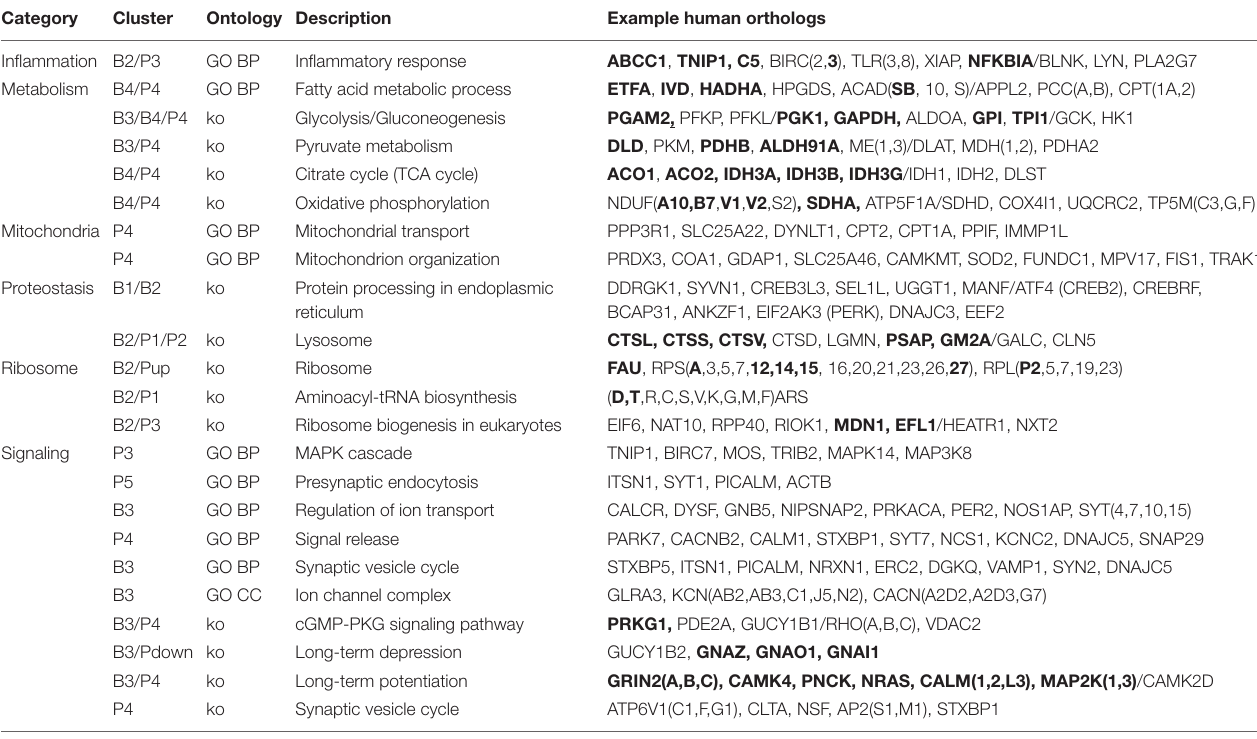
TABLE 3 | Transcriptional profile cluster enrichment analysis results. Category Ontology Description Example human